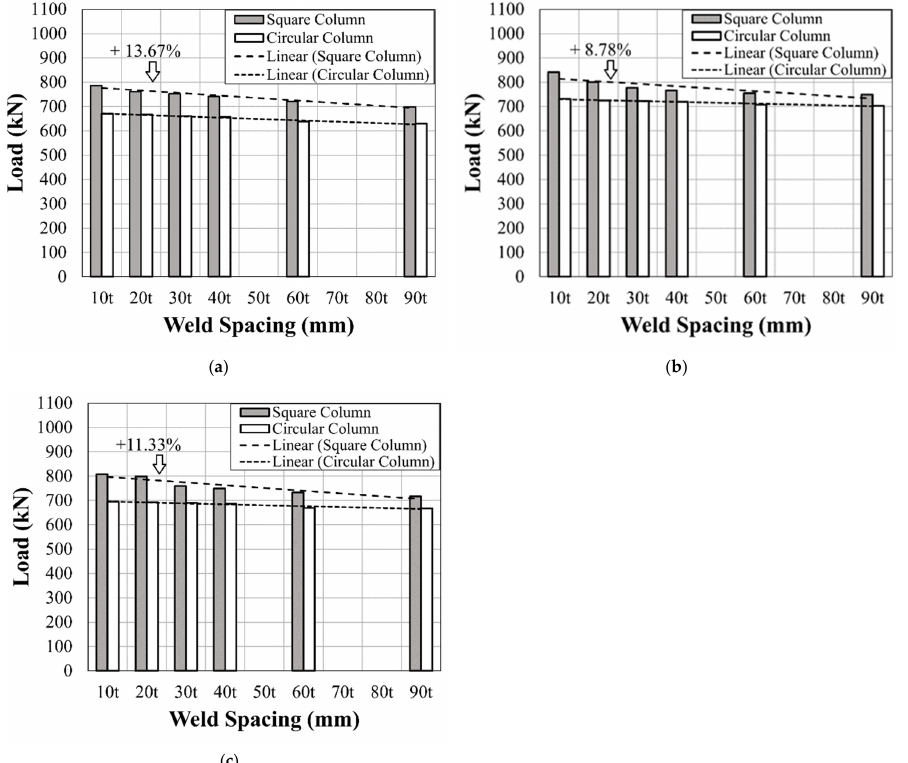
Figure 21. Comparison of the shape of the CFDST column with t s = 2.3 mm on the axial load re- sponse . ( a ) b s =12 mm, t s = 2.3 mm, ( b ) b s = 18 mm, t s = 2.3 mm, ( c ) b s = 25 mm, t s = 2.3 mm.